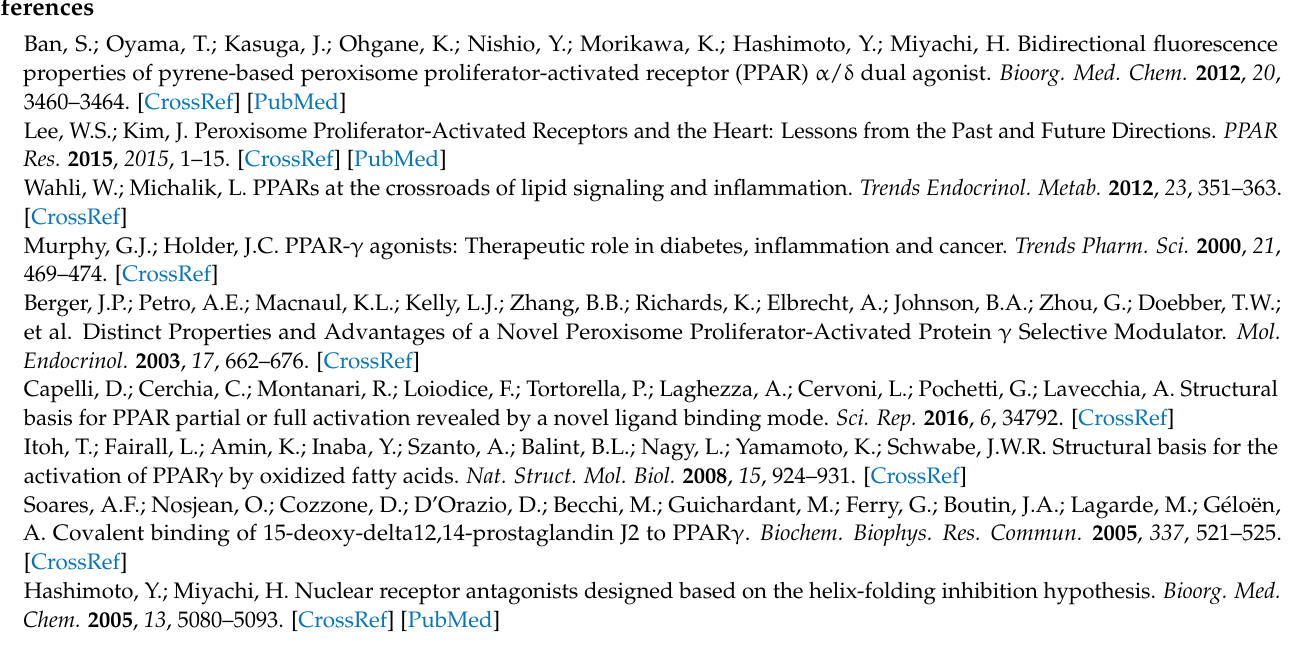
Scheme S2: The proposed mechanism of reaction for synthesis of 6 . Figure S1: Absorption spectrum of 2 and 6 . Figure S2: Kd determination of 6. Figure S3: Binding assay of Farglitazar for hPPAR γ — LBD using 2 . Figure S4: Binding assay of Pioglitazone for hPPAR—LBD using 6 . Figure S5: Binding assay of LT175 for hPPAR γ —LBD using 6 . Spectra of compounds 2 , 5 , and 6 ( 1 H NMR, 13 C NMR). Table S1: Data collection and refinement statistics of the crystal